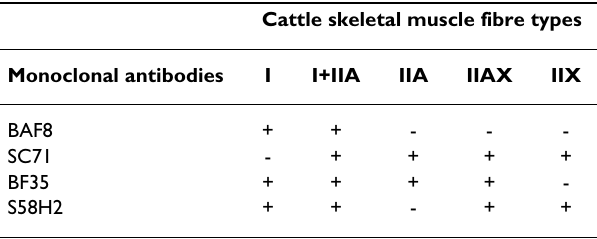
Table 1: Specificity of the monoclonal antibodies used in the immunohistochemistry Cattle skeletal muscle fibre